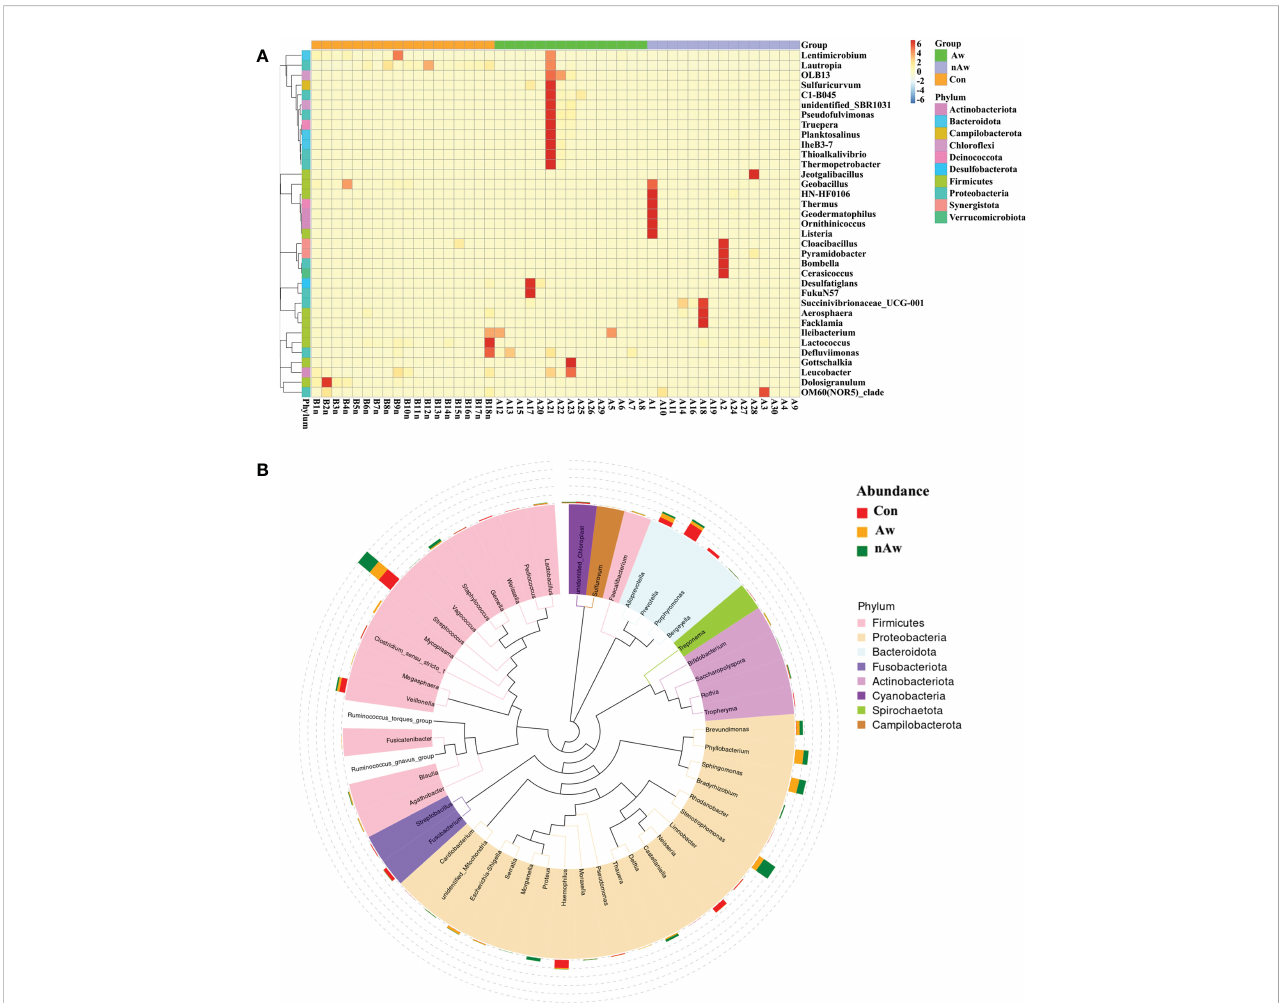
FIGURE 4 Heatmap and Phylogenetic tree at genus level. (A) Cluster heatmap. The plot depicts the relative abundance of each genus (x-axis) within each sample (y-axis). (B) Phylogenetic tree. The branch and fan colors indicate their corresponding gates, and stacked histograms outside the fan rings indicate the abundance distribution. Aw, atopic wheezing group; nAw, non-atopic wheezing group; Con, foreign body aspiration infants as